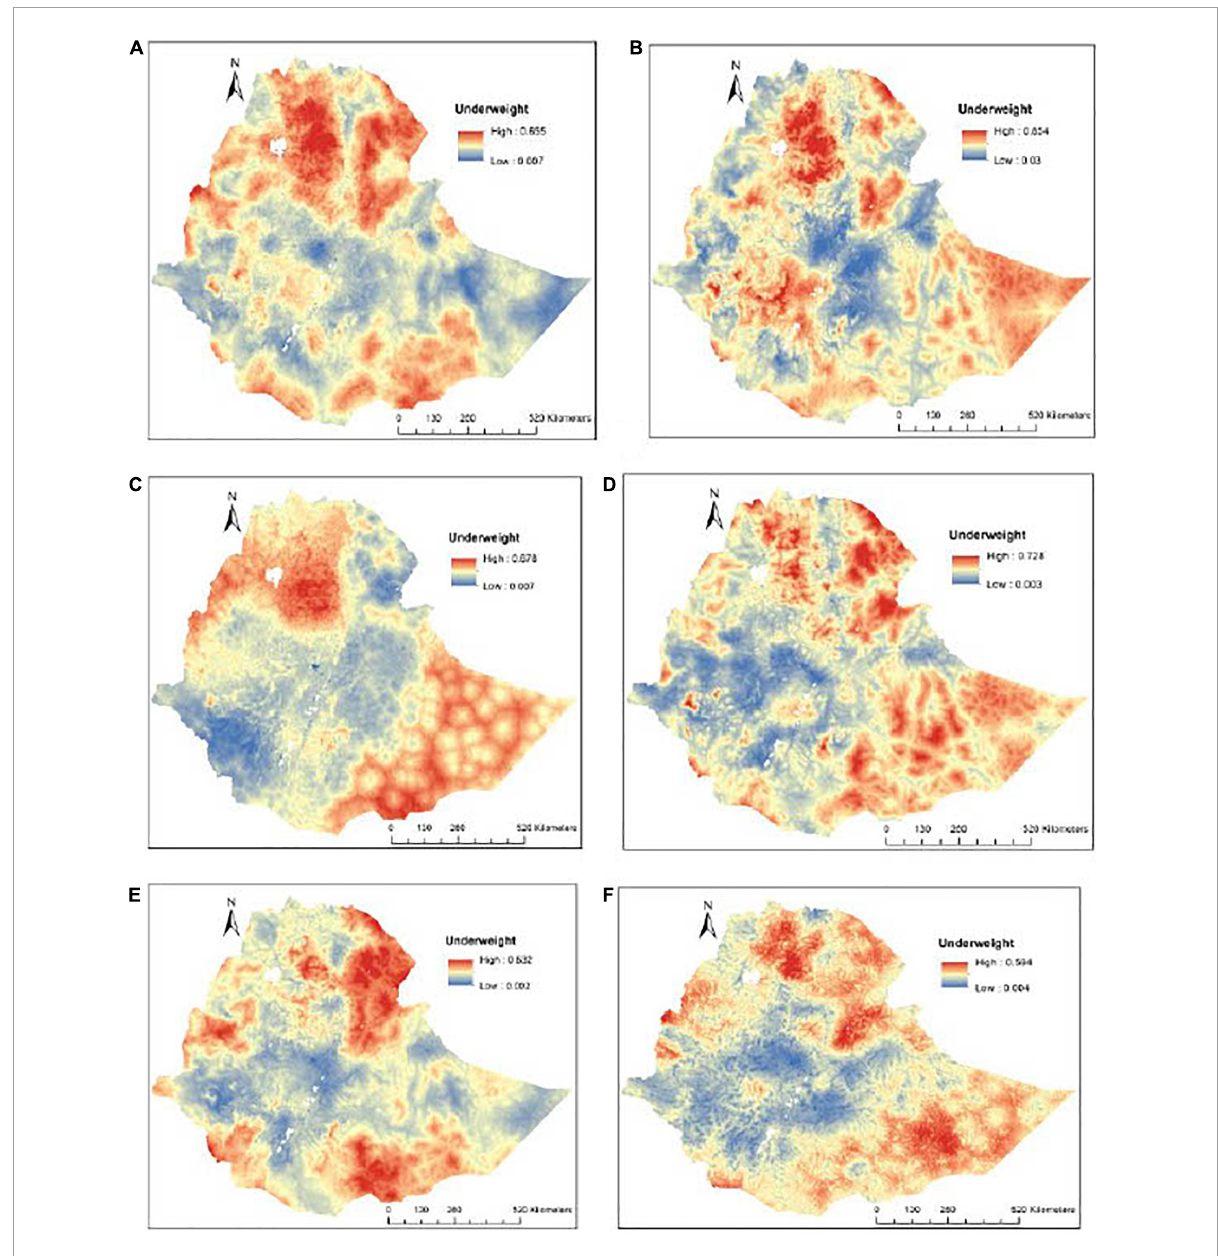
FIGURE3 The predicted geospatial map for the prevalence of underweight in Ethiopia: (A) 2000-2019, (B) 2000, (C) 2005, (D) 2011, (E) 2016, and (F)